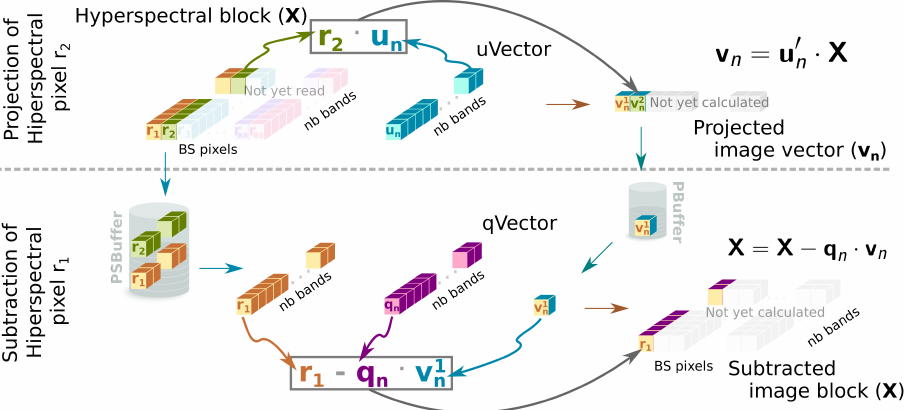
Figure 6. Example of Projection and Subtraction